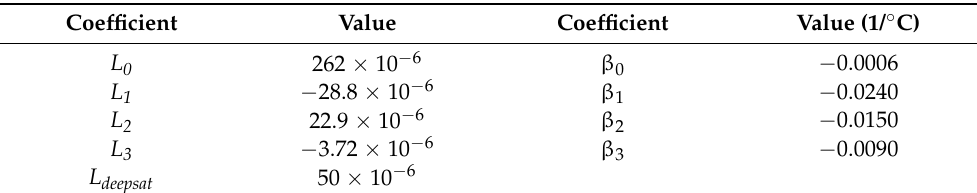
Table 1. Model coefficients of the inductor.